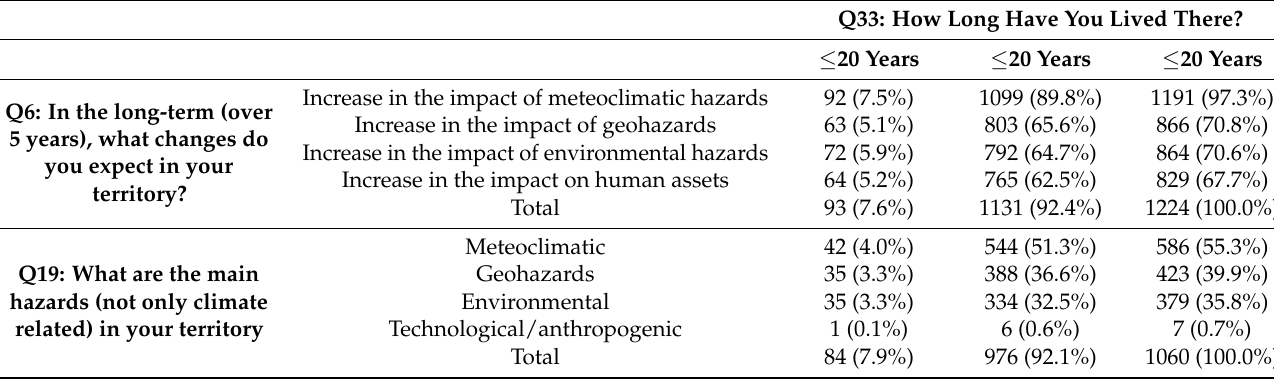
Table A7. Cross table of Q6 and Q33, and Q19 and Q33, with frequencies (percentages) of the answers.